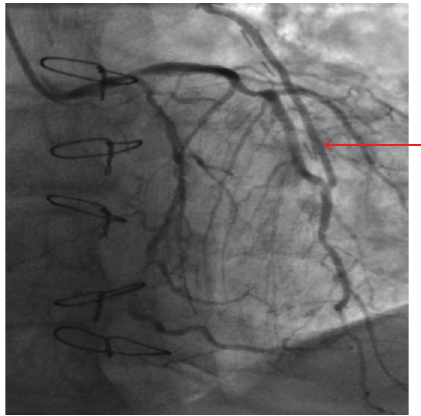
Figure 2: Angiography of the left coronary artery. Optimal anastomosis of the LIMA to the LAD. Retrograde blood flow in the left mammary artery graft to the LAD—later phase (arrow).